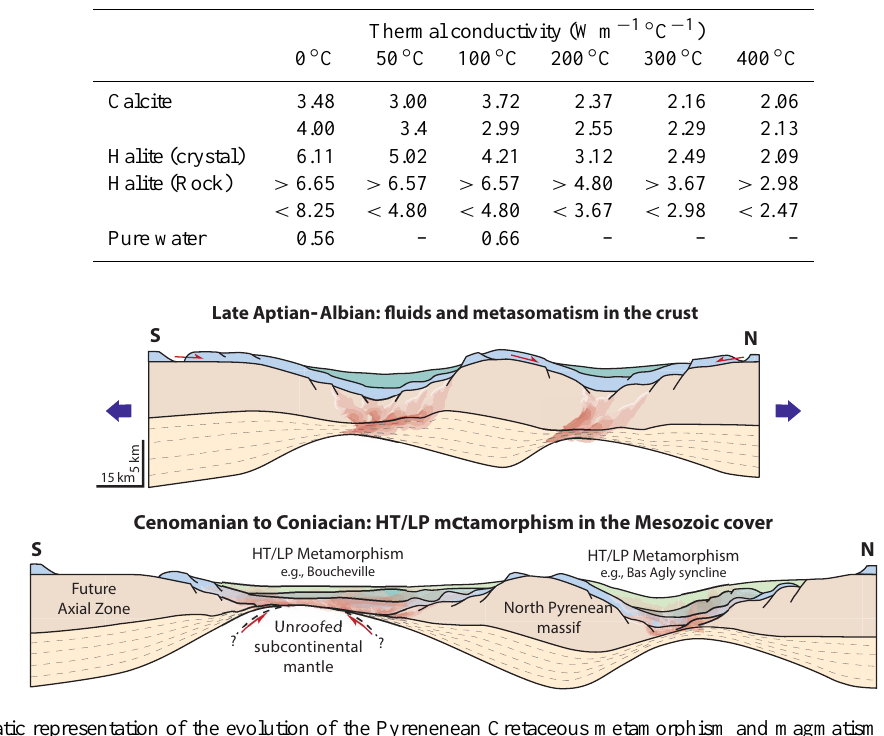
Figure 15. Schematic representation of the evolution of the Pyrenenean Cretaceous metamorphism and magmatism in response to crustal extension. Top: early hydrothermal-dominated phase affecting the crystalline basement. Down: Phase of HT-LP metamorphism, occurring mainly in the pre- and syn-rift sedimentary cover, in response to the attenuation of the continental crust.